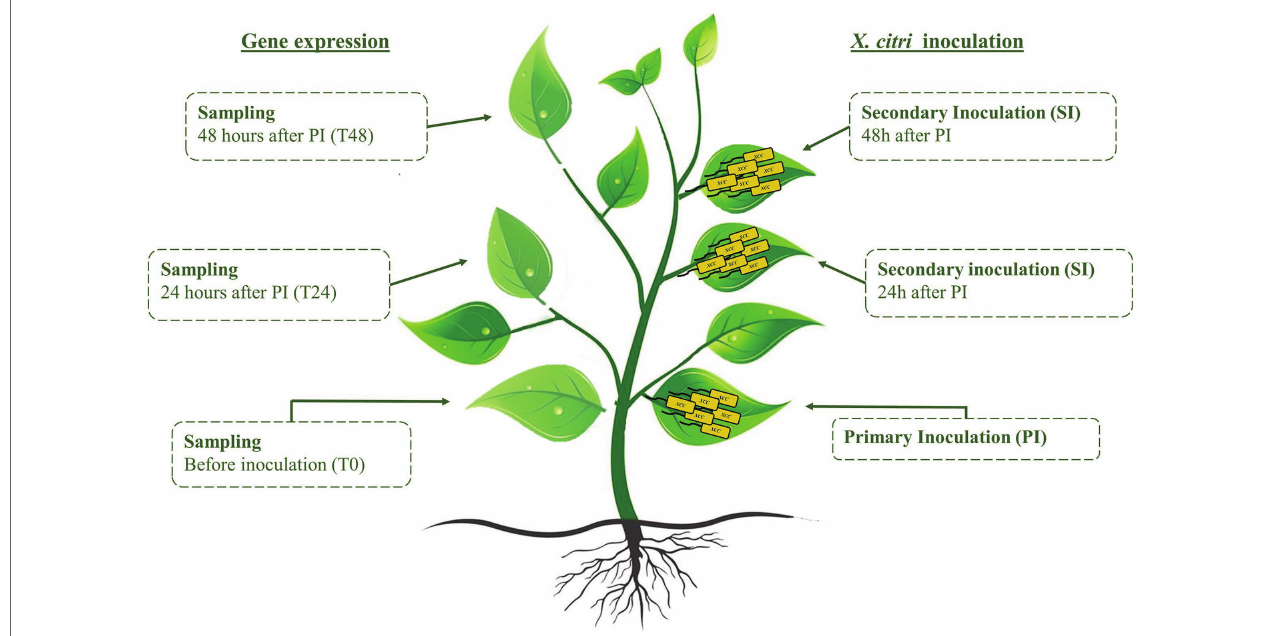
FIGURE 1 | Representative scheme of systemic activation assay. Sampling for gene expression analyses was carried out immediately before inoculation of Xanthomonas citri . Therefore, sampling at T0 was followed by primary inoculation; sampling at T24 and T48 preceded the 24 h and 48 h secondary inoculations,